Question: In one sentence, what is this figure communicating?
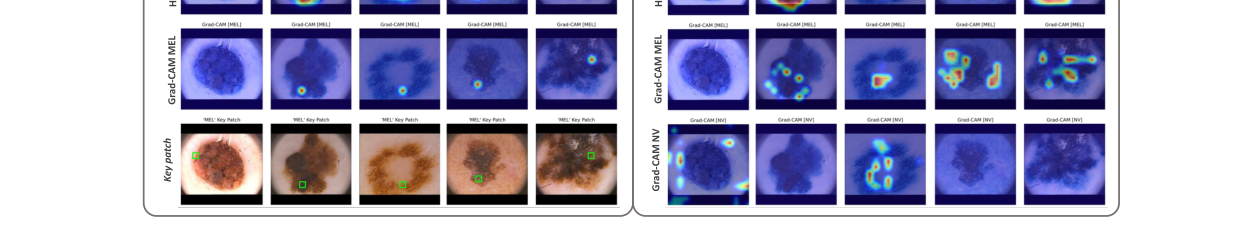
Answer: Visualization of the key patches identified by two different MIL approaches. On the left, we have the instance-level MIL-EN-B3 using max polling, and on the right, we have the instance-level MIL-EN-B3 using the top-k average pooling operator, with k ≈12.5%, The images used for visualization are taken from the PH2 test set and refer to the binary classification task of melanoma vs. nevus.